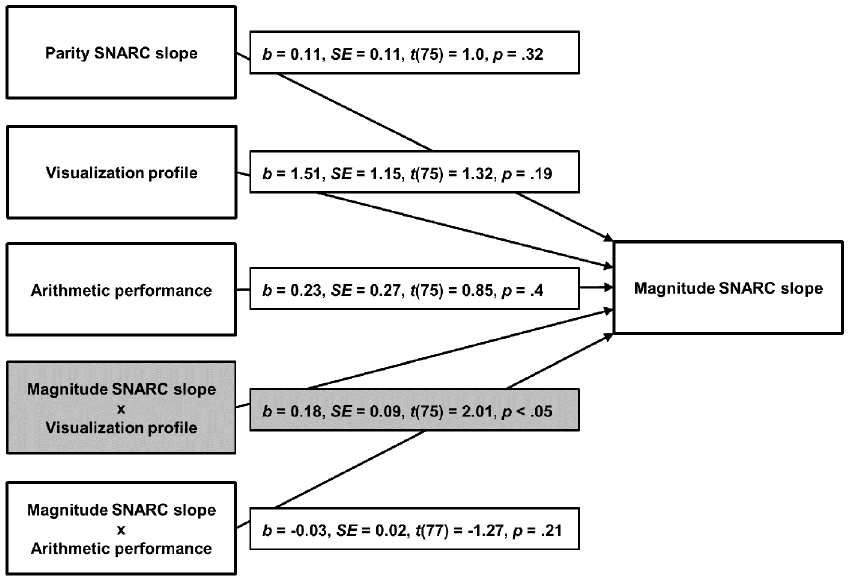
Figure 3. Multiple additive moderation analysis results with unstandardized regression